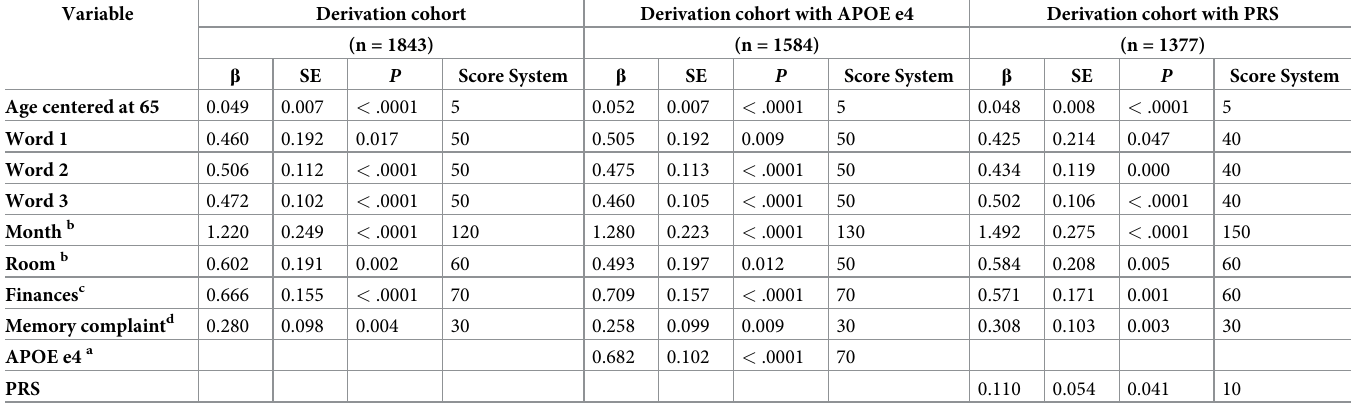
β = estimate, SE = standard error, p = p-value. a